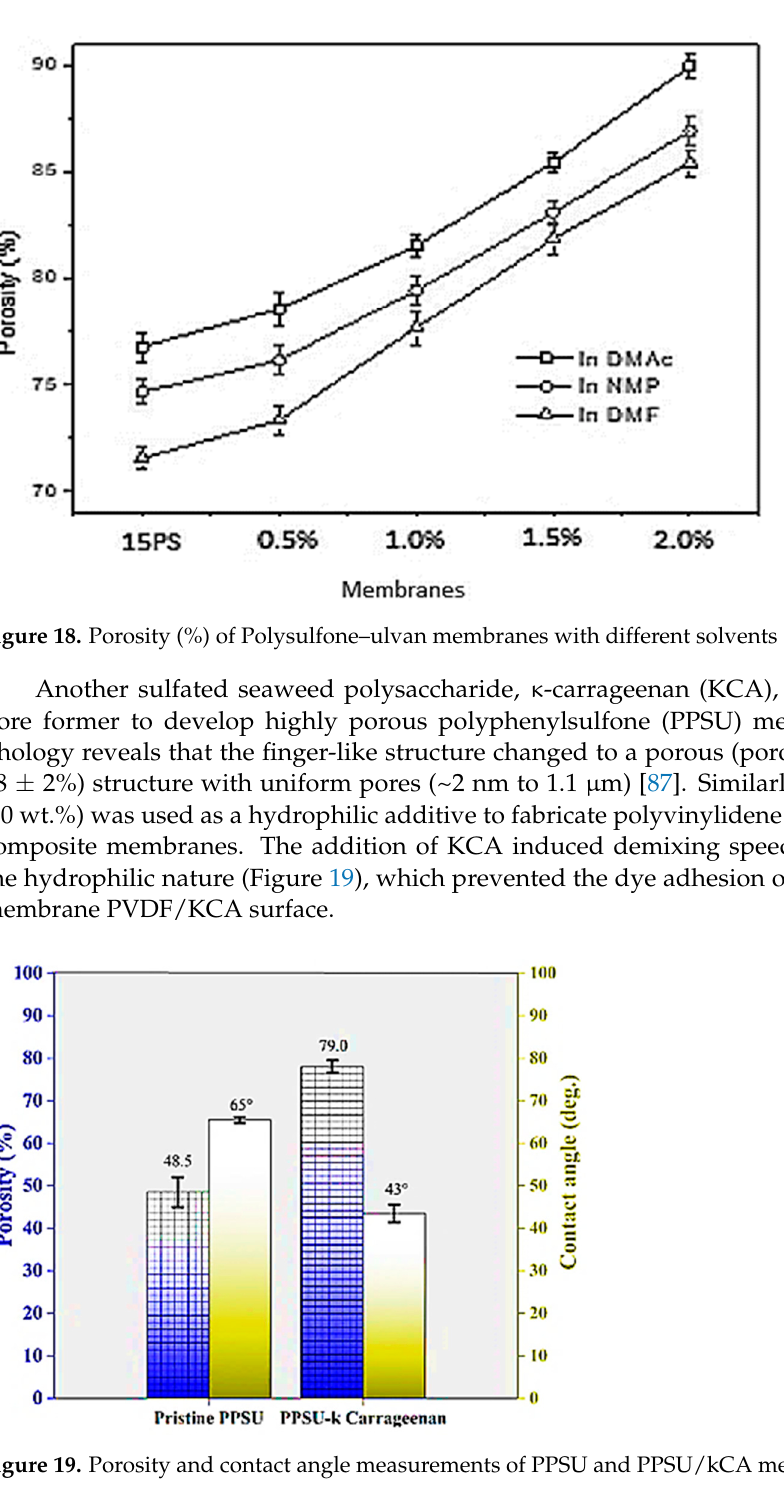
Figure 19. Porosity and contact angle measurements of PPSU and PPSU/kCA membranes [87]. Y.X. Foong et al. [88] applied eco-friendly natural gum Arabic (GA) as a porogen in polysulfone (PSf) membrane fabrication using green solvents. The presence of GA helped to enhance the hydrophilicity and porosity of the membranes. Subsequently, membrane performance was measured through pure water flux and Congo red (CR) rejection capability. In the presence of DMSO as a green solvent, the membrane displayed a comparable membrane performance (Figure 20) to the membrane prepared by using conventional N-methyl-2-pyrrolidone (NMP) as a solvent. GA’s impact was thus confirmed through porosity, pore size and Congo red (CR) rejection capability. Apart from excellent